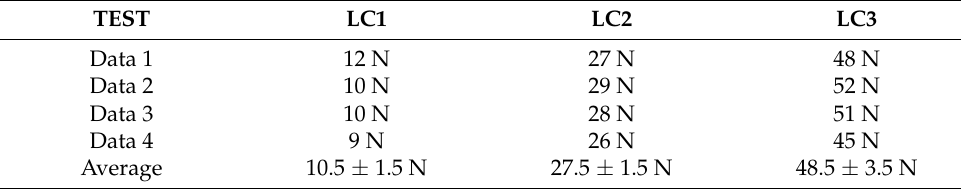
Figure 8. Optical images of WC:C-coated sample after nano-scratch test showing ( a ) LC1, ( b ) LC2 and ( c ) LC3. Table 3. Experimental data derived from the scratch test with the corresponding values of the critical load (LC1, LC2 and LC3) for the DLC WC:C coating sample.